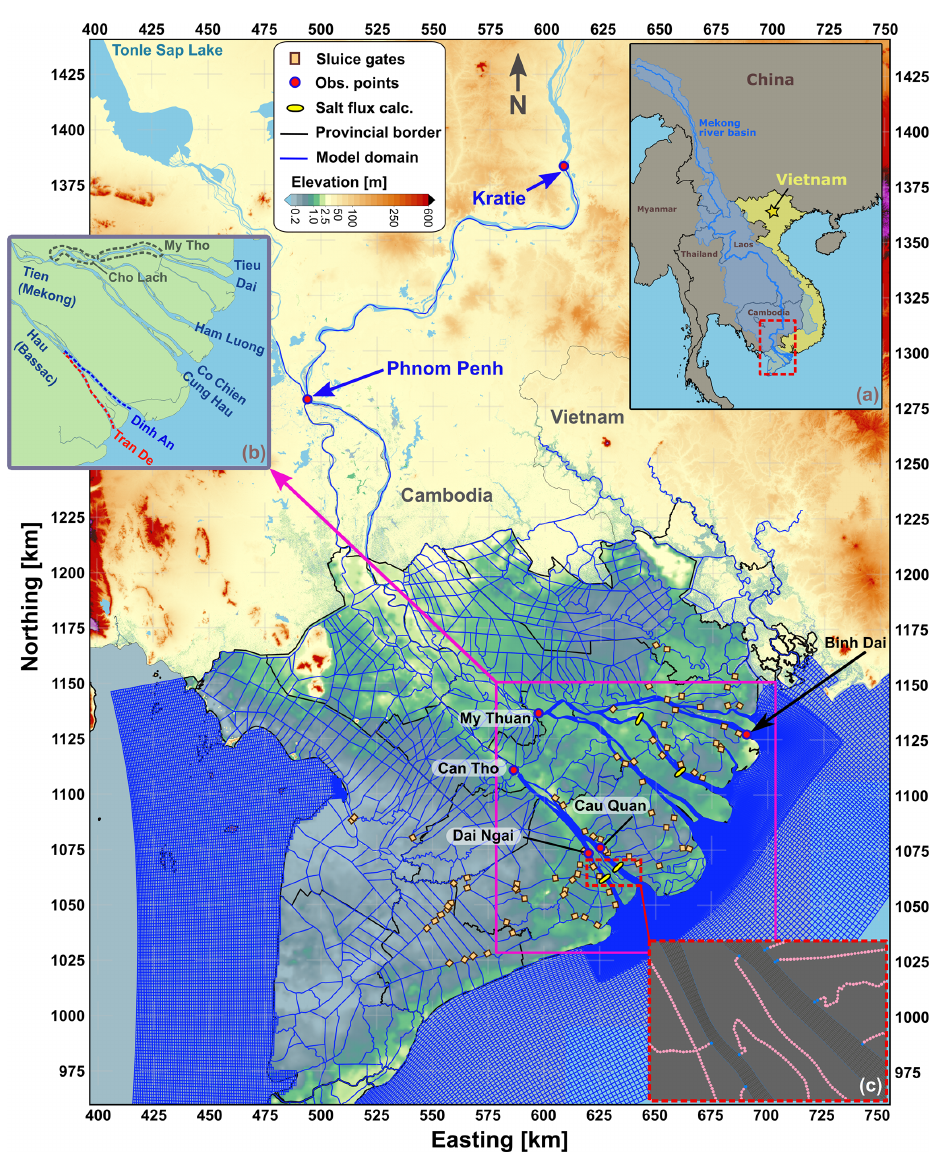
Figure 1. Digital elevation map of the Mekong Delta (Minderhoud et al., 2019), the numerical domain developed for this study, and the observation points and the studied cross sections. (a) An overview of the Mekong River Basin and the Mekong Delta. (b) The salinity measurement trajectories along the Dinh An and Tran De channels (dotted lines) and the names of estuarine distributary channels, with the grey dashed lines highlighting the regional names of some river stretches. (c) Top view of part of the 2DV–3D grid (coord. system: WGS-84 UTM